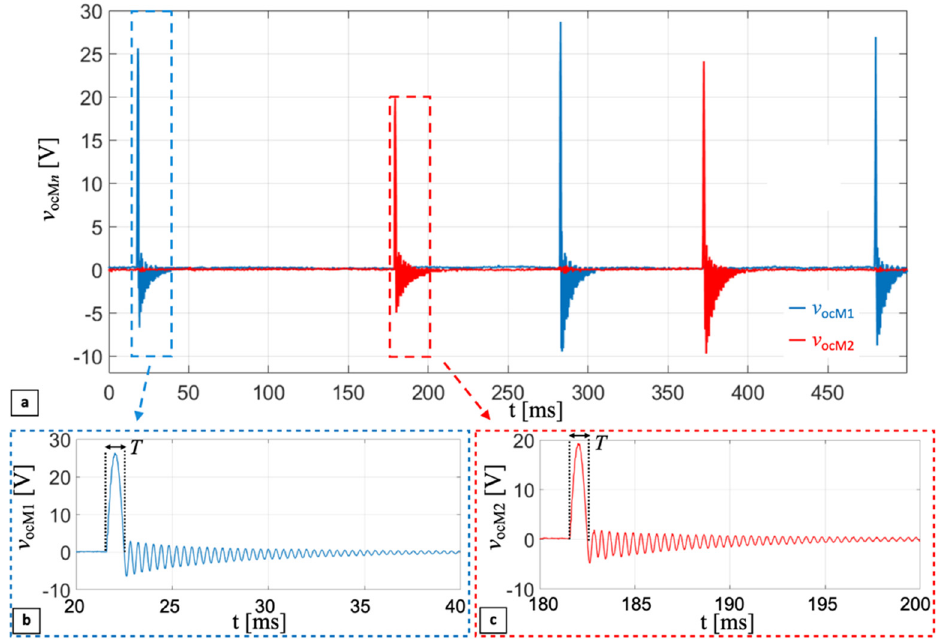
Figure 12. Measured open-circuit voltages, v ocM n (t), of piezoelectric converter PC1 (blue curve) and PC2 (red curve) of the mono-axial harvester ( a ). Enlarged images of a single impact happening against PC1 ( b ) and PC2 ( c ).